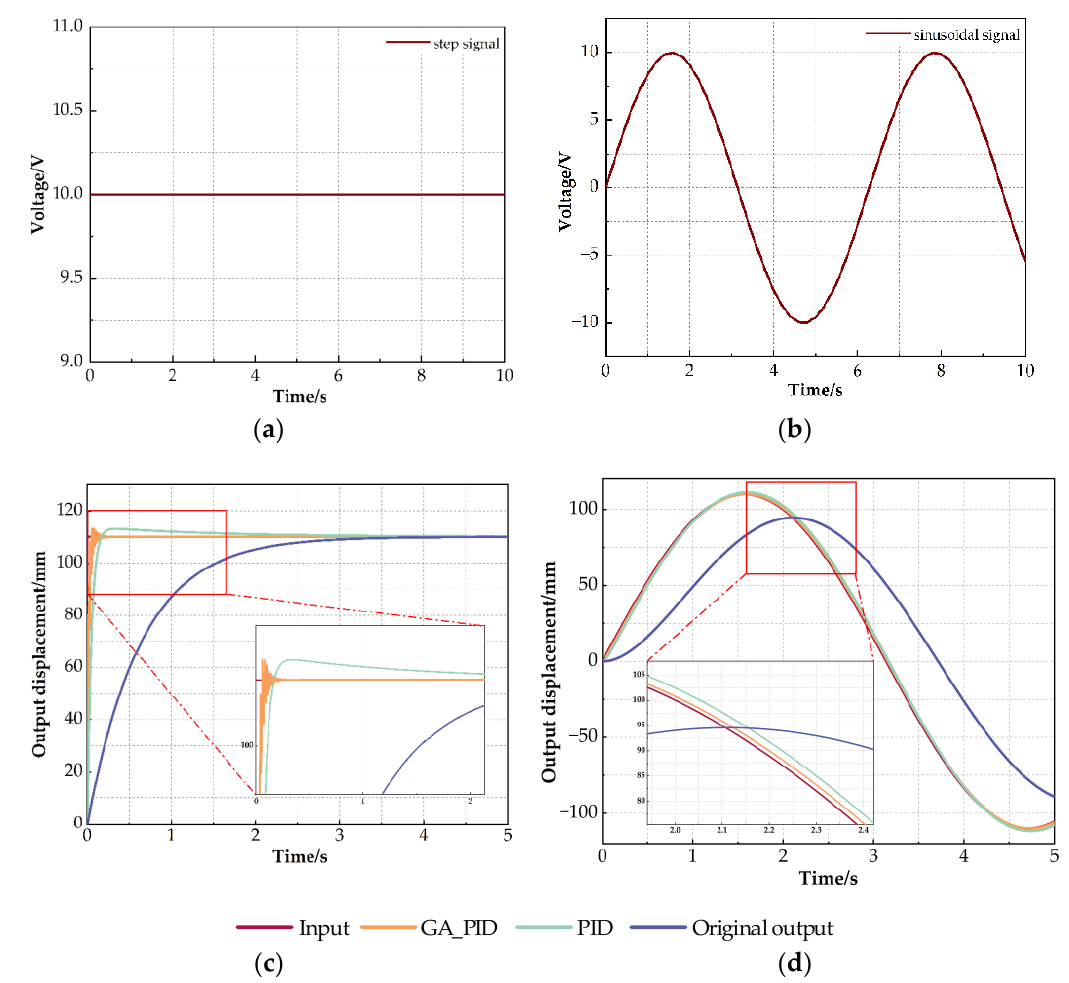
Figure 8. Optimization of PID simulation diagram by GA.